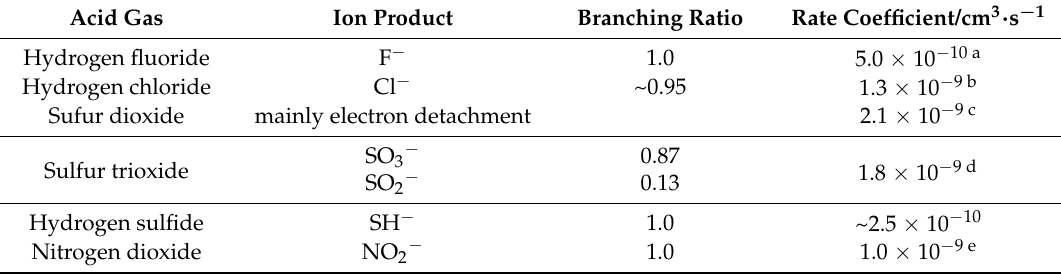
Table 4. O − reactions of acid gases, nitrogen carrier gas, and flow tube at 120 ◦ C.